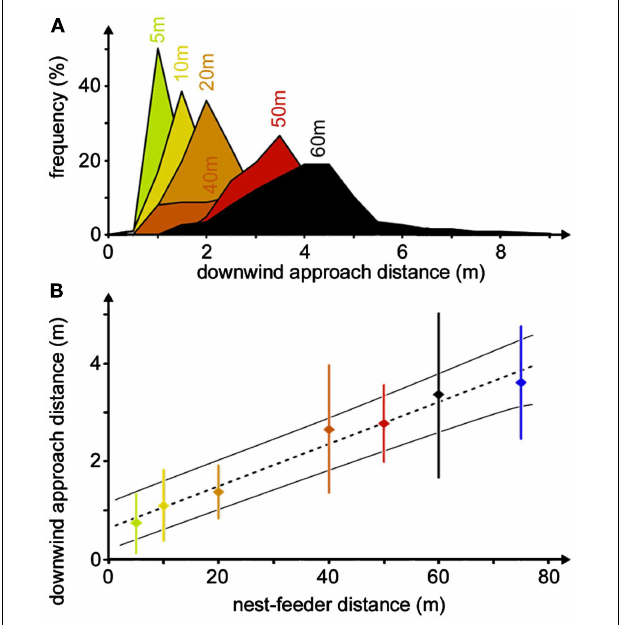
FIGURE 6 | Compensation of navigation inaccuracy by downwind approach. (A) Distributions of downwind approach distances for different nest-feeder distances. Histograms were recorded at the nest-feeder distances noted above the peak bins (bin widths 0.5m). Different histograms are distinguished by different colors. For the different histograms, the numbers of ant individuals were between 8 and 29, yielding between 42 and 747 recordings, except for 75m nest-feeder distance with only three ants and six recordings (seeWolf andWehner, 2005). (B) The same data set is shown as a plot of downwind approach distance against nest-feeder distance. Dotted line indicates the best-fit regression, thin lines mark 95% confidence intervals. Measurements for each individual were pooled before calculating means, SD, and regression line. Color code as in (A)